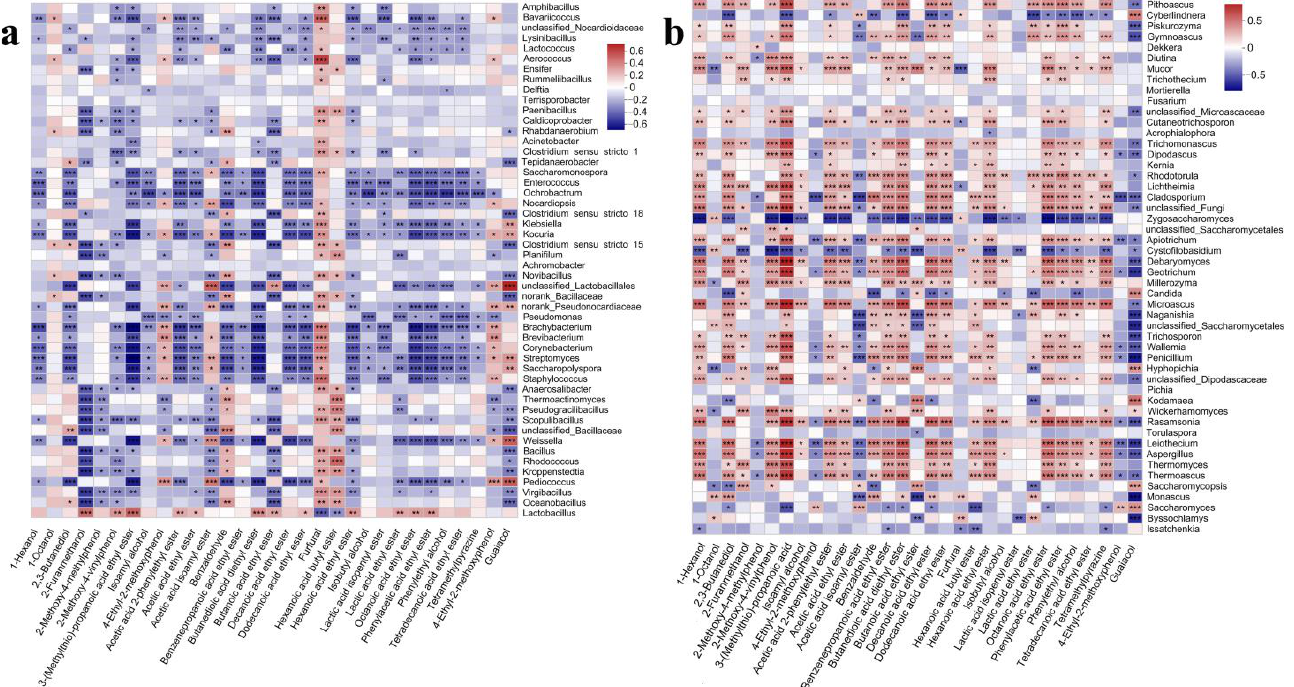
Figure 8. Correlation analysis of flavor chemicals and microbial community in the fermented grains of sauce-flavor Baijiu. Red represents a positive correlation, and blue represents a negative correlation. ( a ), bacteria with flavor chemicals. ( b ), fungi with flavor chemicals. * 0.01 < p ≤ 0.05, ** 0.001 < p ≤ 0.01, *** p ≤ 0.001.